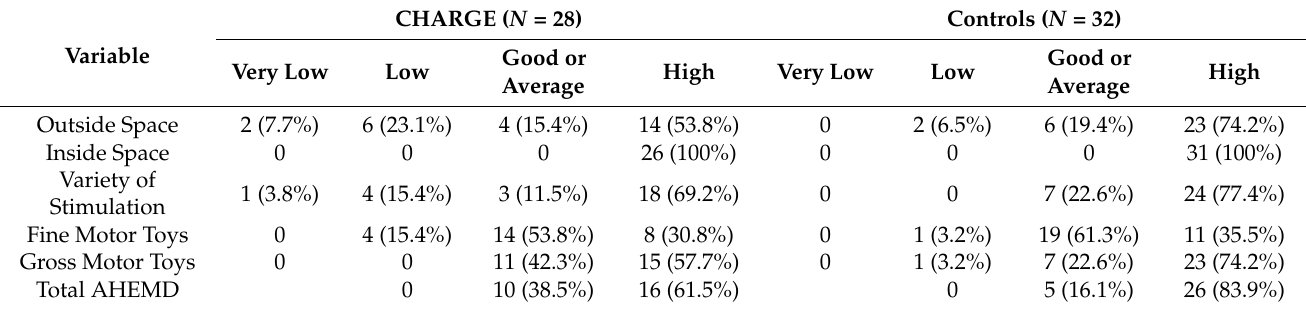
Table 5. Frequencies of affordance level for AHEMD scores for children with and without CHARGE syndrome.